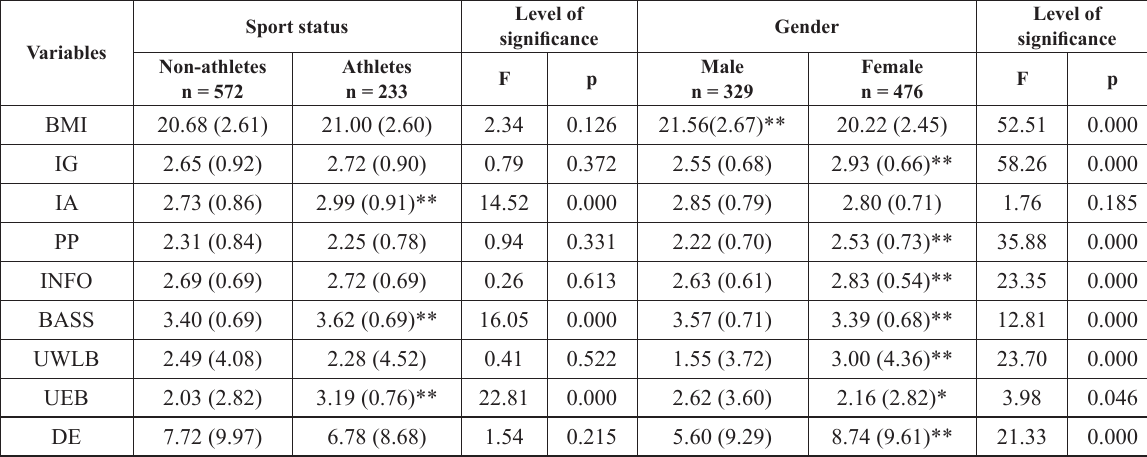
Table 1. Means and standard deviations for all variables for sport status and gender groups Variables